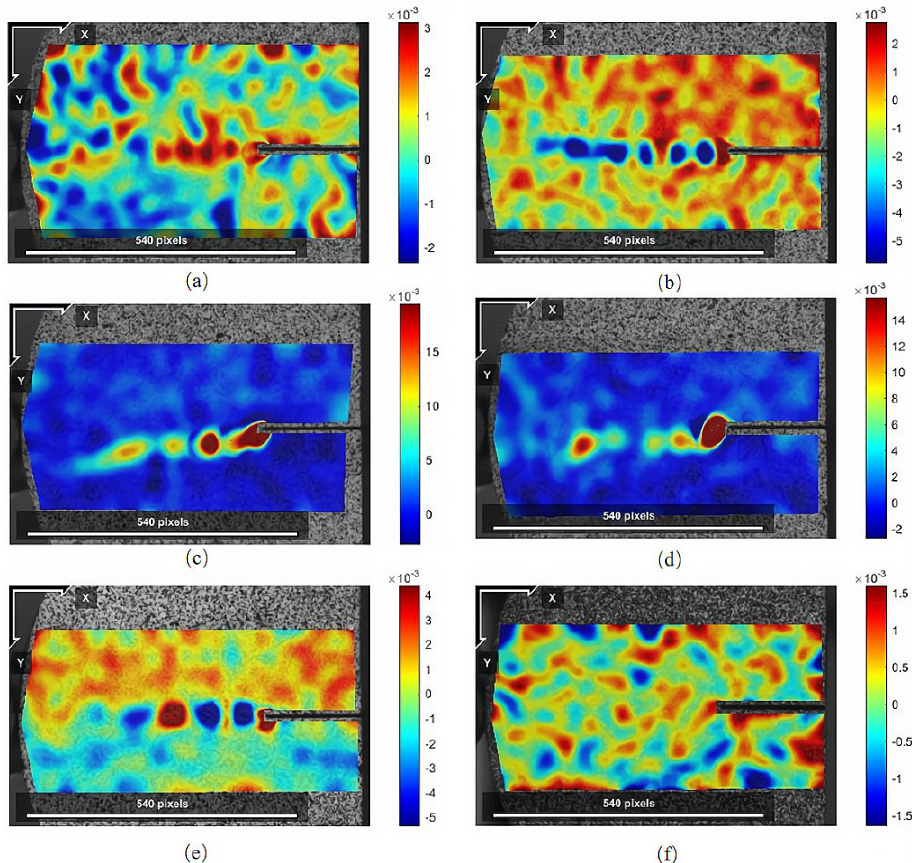
Figure 18. The distribution field of shear strain ε xy before the fracture of different NSCB specimens: ( a ) ε xy for S1; ( b ) ε xy for S2; ( c ) ε xy for A1; ( d ) ε xy for A2; ( e ) ε xy for D1; ( f ) ε xy for D2.